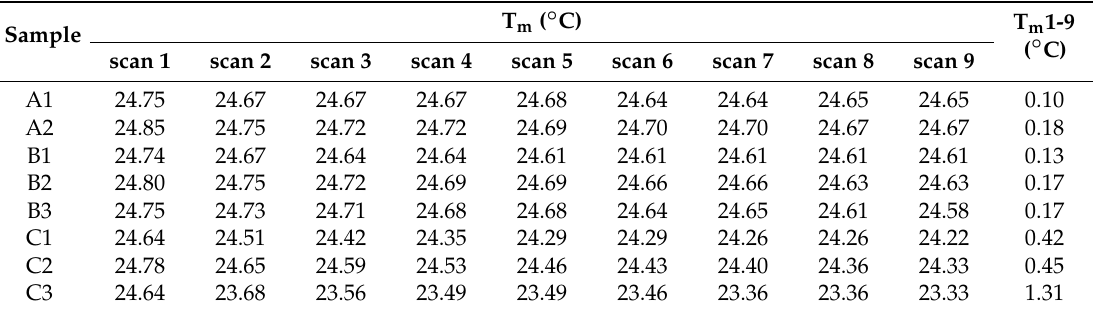
Table 4. Transition temperature (T m ) values determined for each DSC scan during in vitro experiments on IDE-loaded SLN interactions with MLV liposomes and ∆ T m difference between scan 1 and scan 9 ( ∆ T m